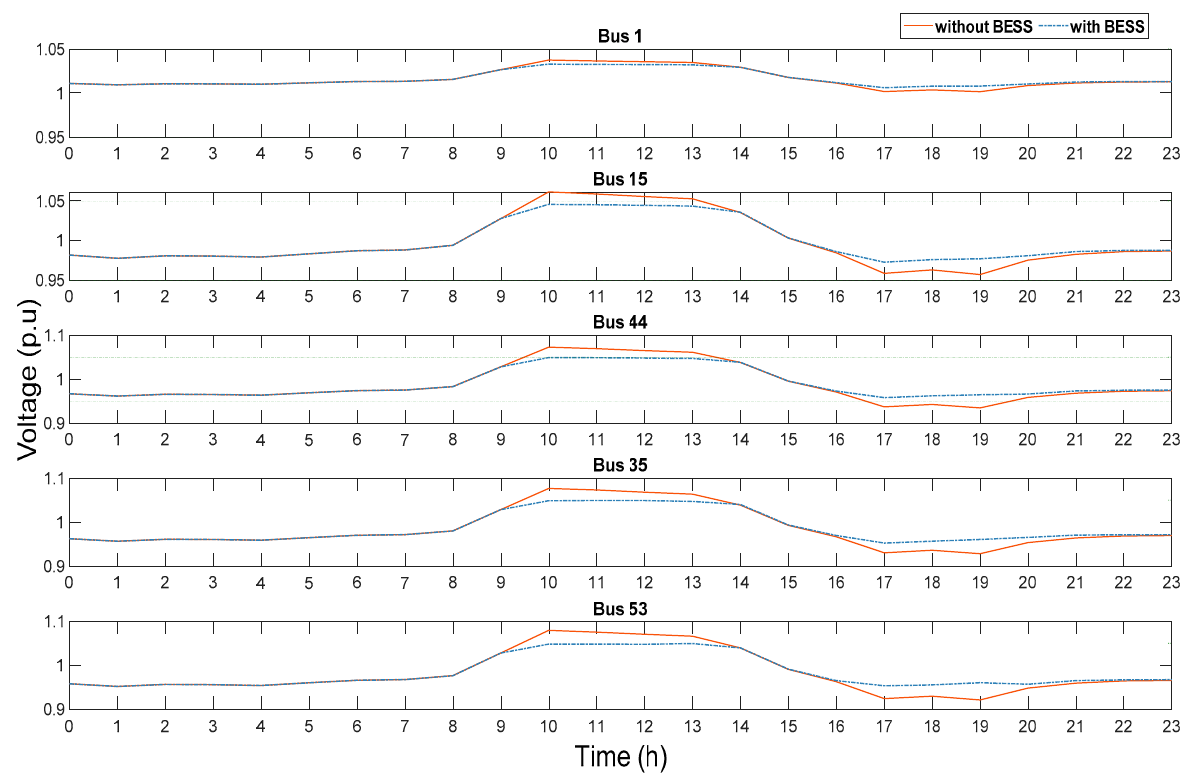
Figure 10. Network daily voltage profile with and without BESS at different load buses.